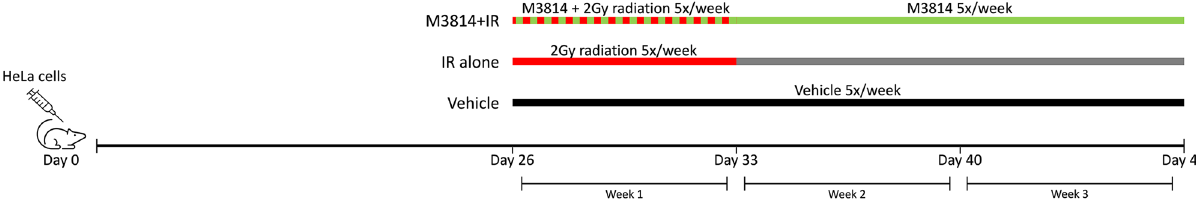
Figure 1. Three million HeLa cells were injected subcutaneously into the flank of eleven 11 athymic nude female mice. The animals were separated into three groups: vehicle (n = 3), IR alone (n = 4), and M3814 + IR (n = 4). Treatment started 26 days after injection. The vehicle group received M3814 vehicle control by oral gavage once daily 5 days per week for weeks one to three. The IR alone group received 2 Gy radiation 5 days per week for week one. The combined M3814 + IR group received peposertib (M38814) 50 mg/kg by oral gavage once daily 5 days per week for weeks 1–3, and 2 Gy radiation 5 days per week for week one. Radiation was administered 60 min after M3814 drug administration.